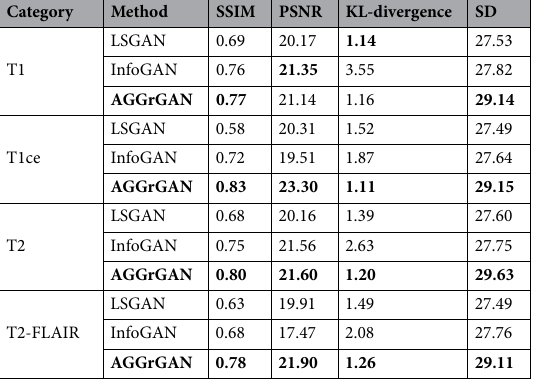
Table 4. Quantitative comparison of performance between existing GAN architectures like LSGAN, InfoGAN and the proposed AGGrGAN applied on the the BraTS 2020 dataset. Values in bold signify that they are—(i) the metric-wise best value obtained for the corresponding class for Tables 1, 2, 3, 4 and (ii) case-wise best performance obtained for a particular dataset.